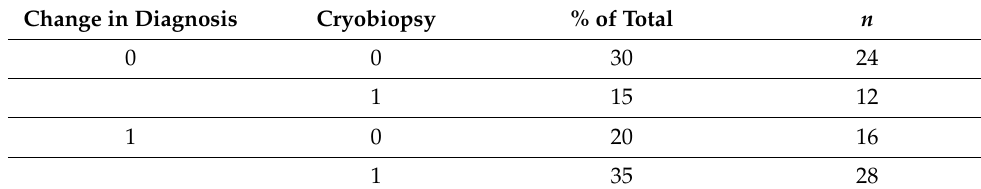
Table 3. Association between cryobiopsy and disease. Change in Diagnosis Cryobiopsy % of Total n 0 0 30 24 1 15 12 1 0 20 16 1 35